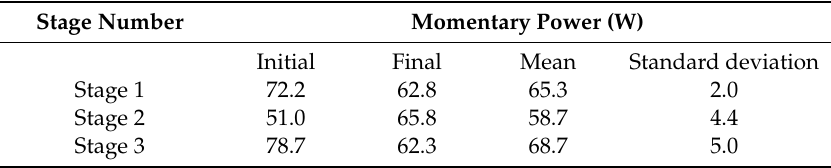
Table 6. TE power supply values determined for all stages of